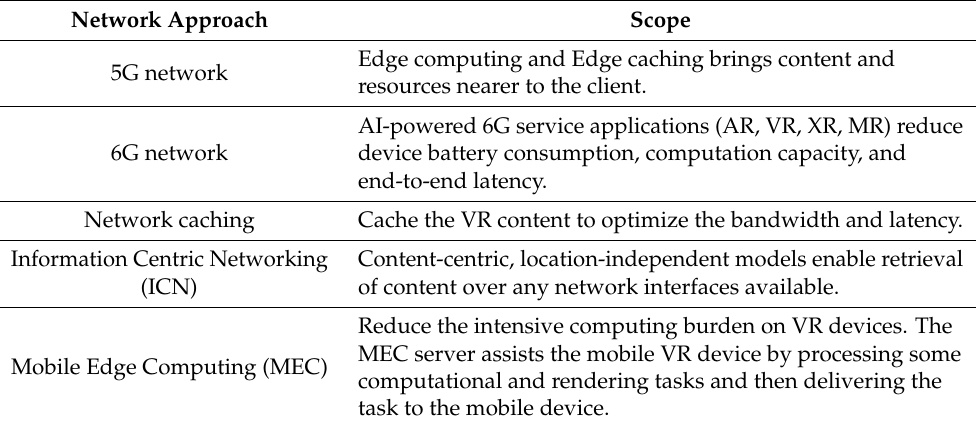
Table 6. Comparison of network